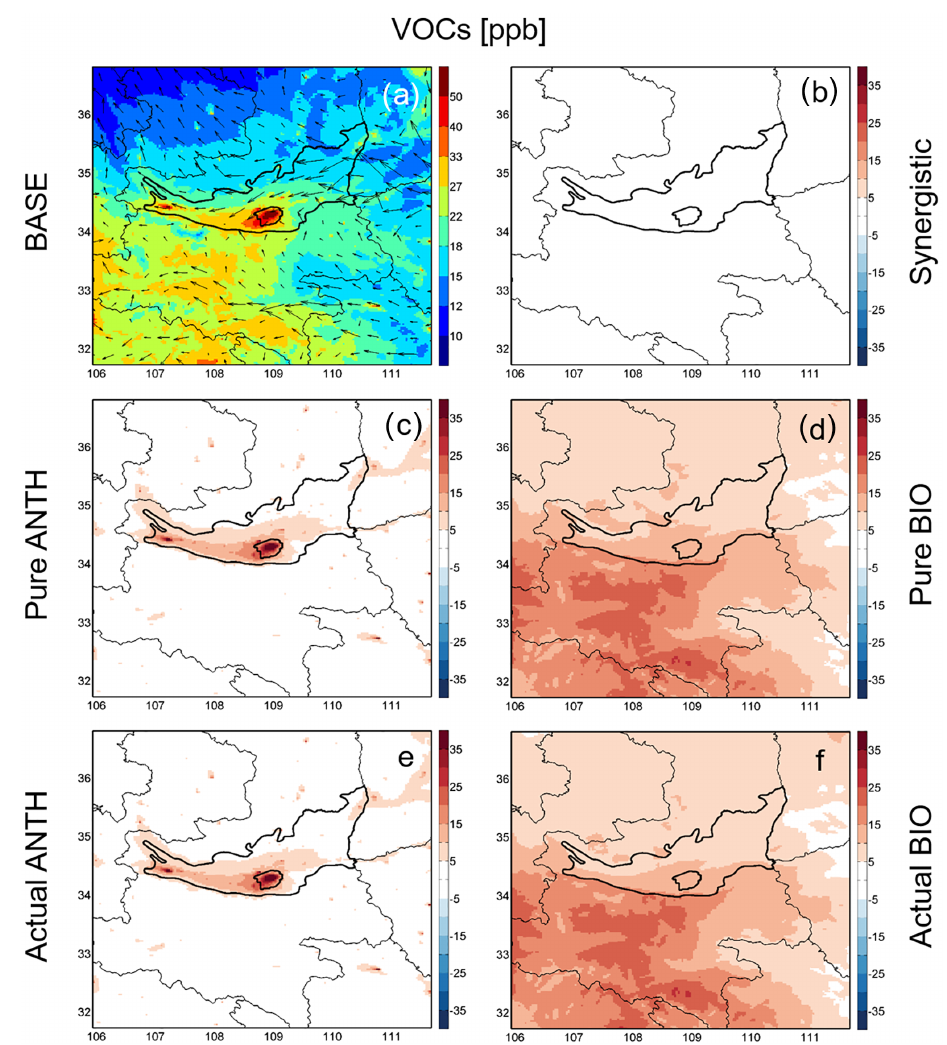
Figure 4. Spatial distributions of monthly mean concentrations of VOCs in August 2011. Panel (a) is the result from the BASE simulation, overlaid with simulated wind vectors. Panels (b–f) are simulated VOCs concentrations contributed from synergistic anthropogenic and biogenic, pure anthropogenic, pure biogenic, actual anthropogenic, and actual biogenic sources,